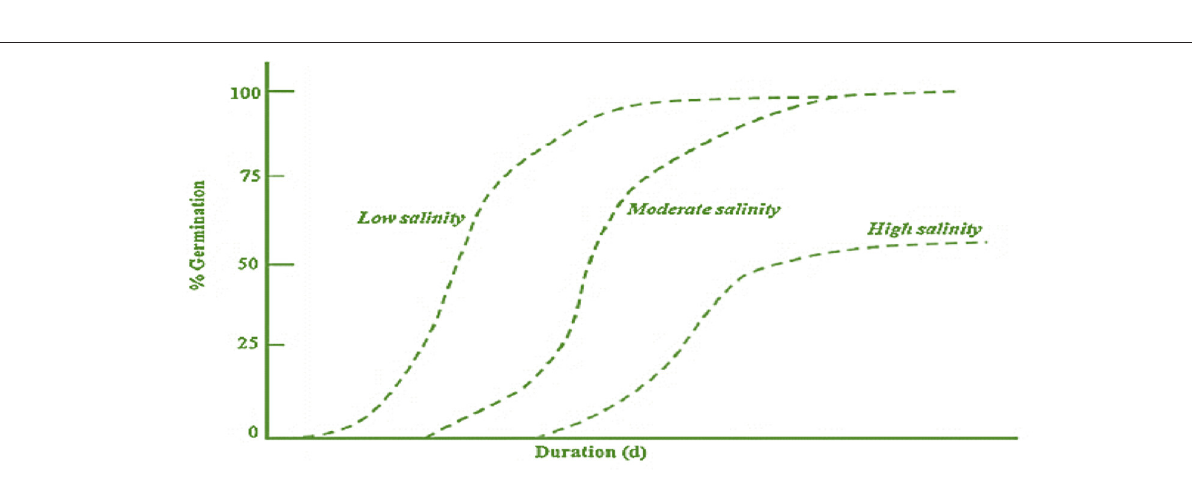
growth regulators etc. for boosting cereals germination in saline environment, otherwise significant decline in germination could lead food crisis in